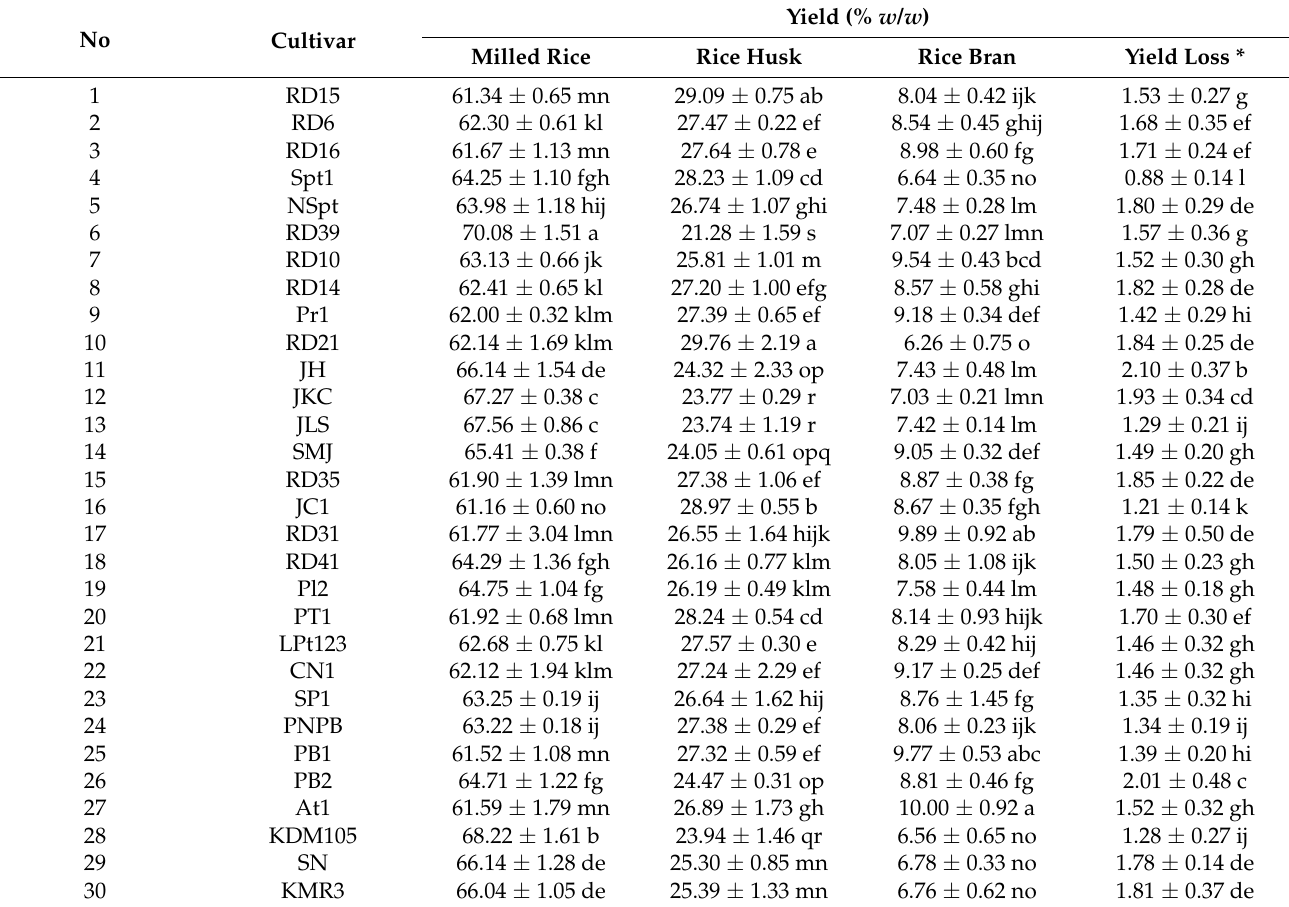
Table 1. Yield of milled rice, rice husk, and rice bran fractions of the 38 rice